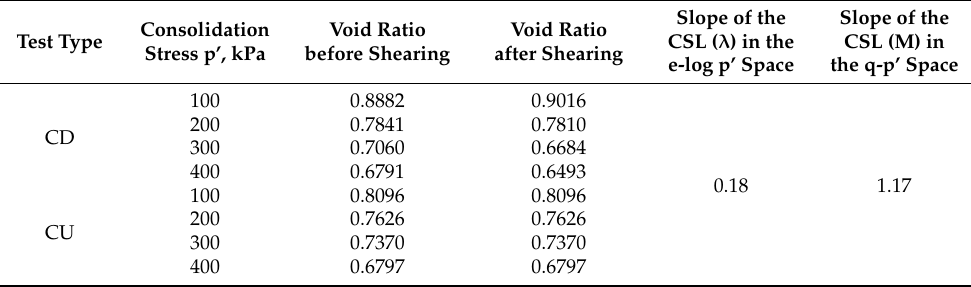
Table 3. Testing conditions of the drained and undrained shearing tests of the intact soil.